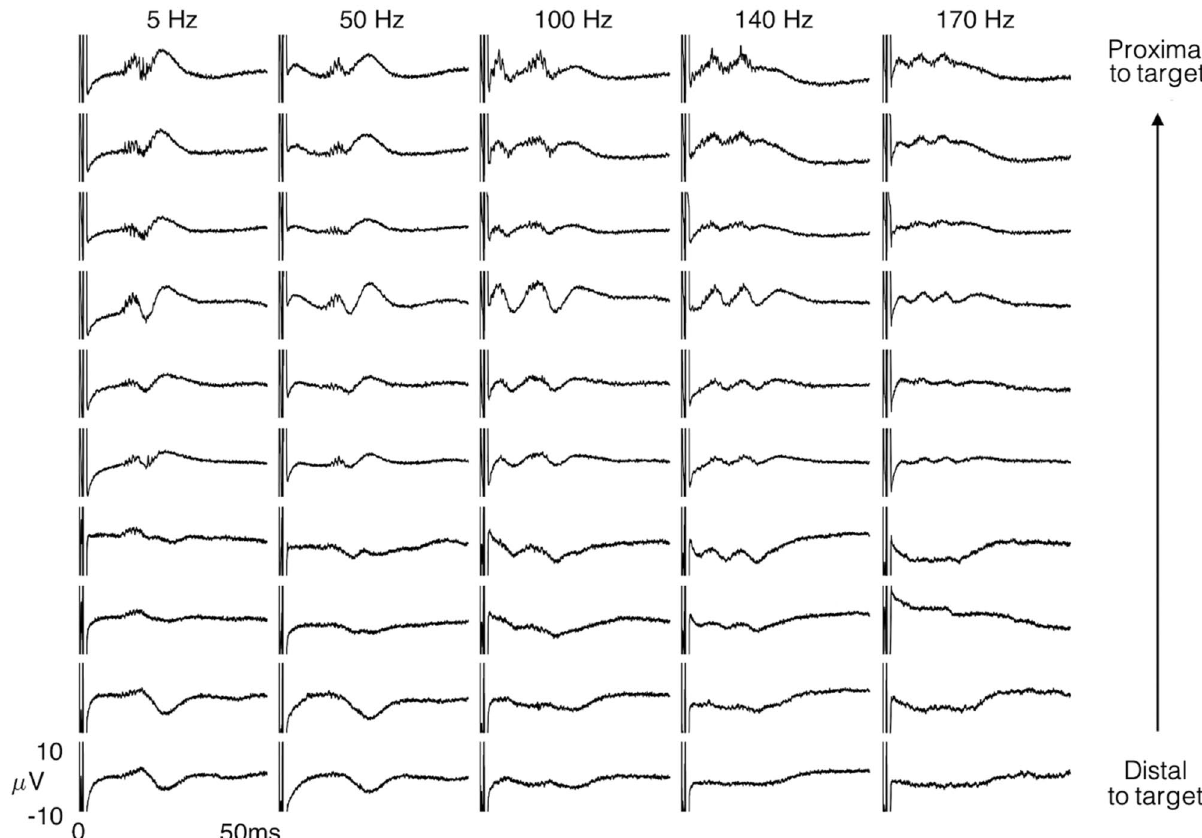
Figure 3. Robust evoked responses are observed in the microelectrodes proximal to the target thalamic nuclei, with a change in the amplitudes as a function of burst frequency. Representative evoked VIM responses are presented for each of the 10